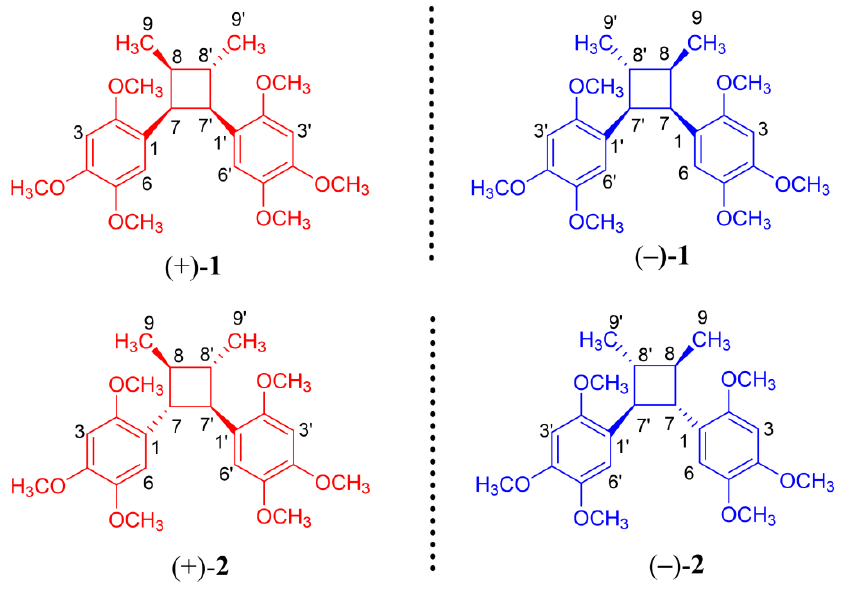
Figure 1. Structures of compounds 1 and 2 .